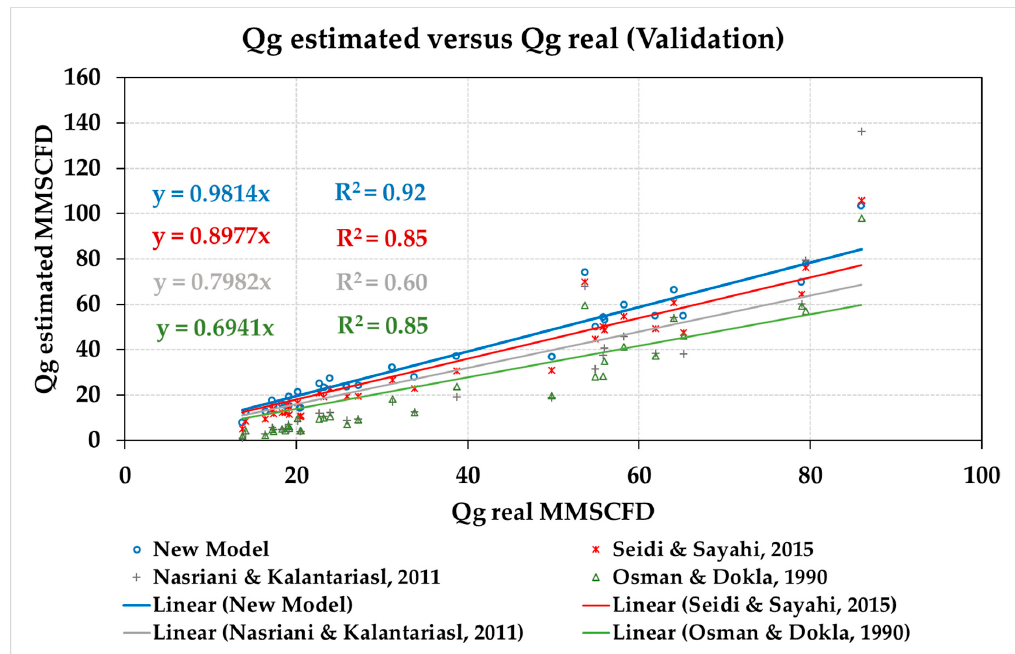
Figure 3 . Estimated gas flow rate versus real gas flow rate (validation) . Figure 3. Estimated gas flow rate versus real gas flow rate (validation). Table 3. A comparison of six di ff erent measures of accuracy corresponding to di ff erent models for the validation of the new model using an additional production data set (32 data points).